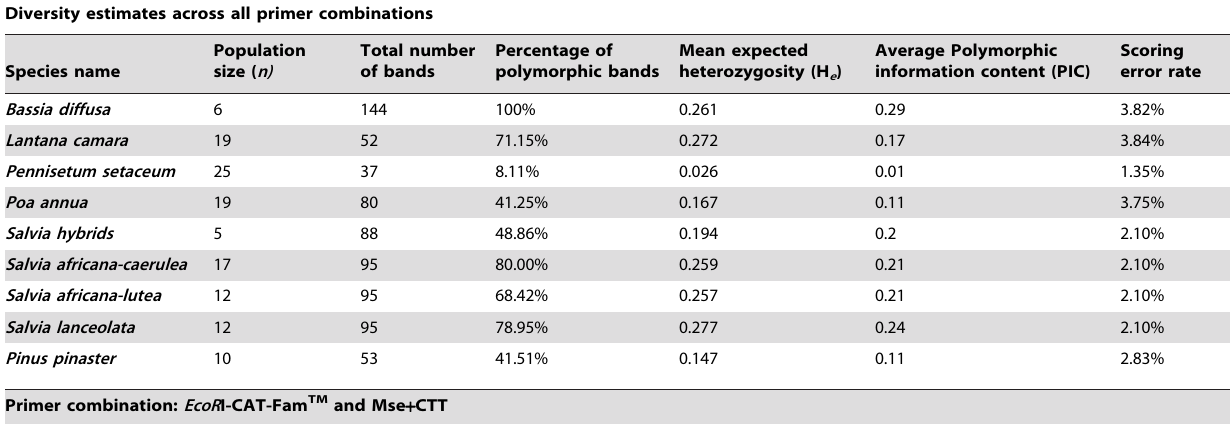
Diversity estimates across all primer